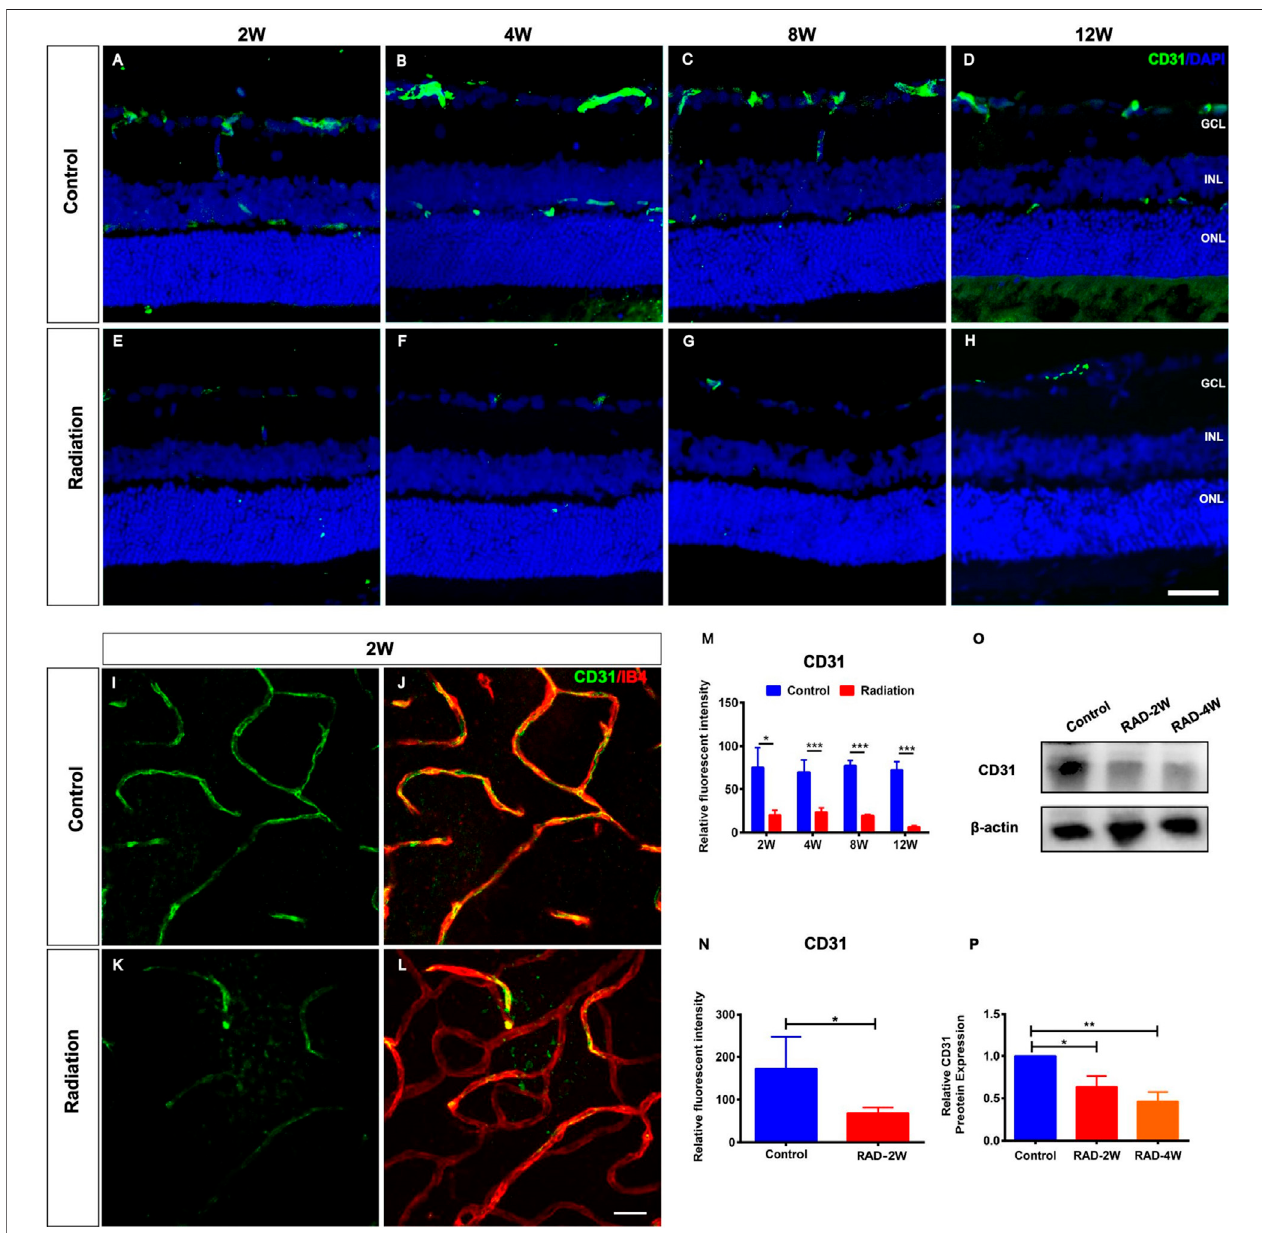
FIGURE 1 | Spatiotemporal changes of CD31 + endothelial cells in the irradiated LE rats. (A – H) : Representative images of CD31 + (Green) retinal endothelial cells in control and irradiated rat retina after 2, 4, 8, and 12 weeks radiation. Scale bar: 50 μ m. (I – L) : The retinal blood vessels showed by CD31 and IB4 staining in the wholemount retina. Scale bar: 50 μ m. (M) : The fl uorescence intensity statistics of CD31 in retinal sections. (N) : The fl uorescence intensity statistics of CD31 of retinal blood vessels in the wholemount retina. (O) : WB analysis of the protein expression of CD31 in the retina. (P) : The statistics of WB grayscale of CD31 protein expression. N = 3. Data are depicted as means ± SEM. (* p < 0.05, *** p < 0.001). GCL: ganglion cell layer; INL: inner nuclear layer; ONL: outer nuclear layer.